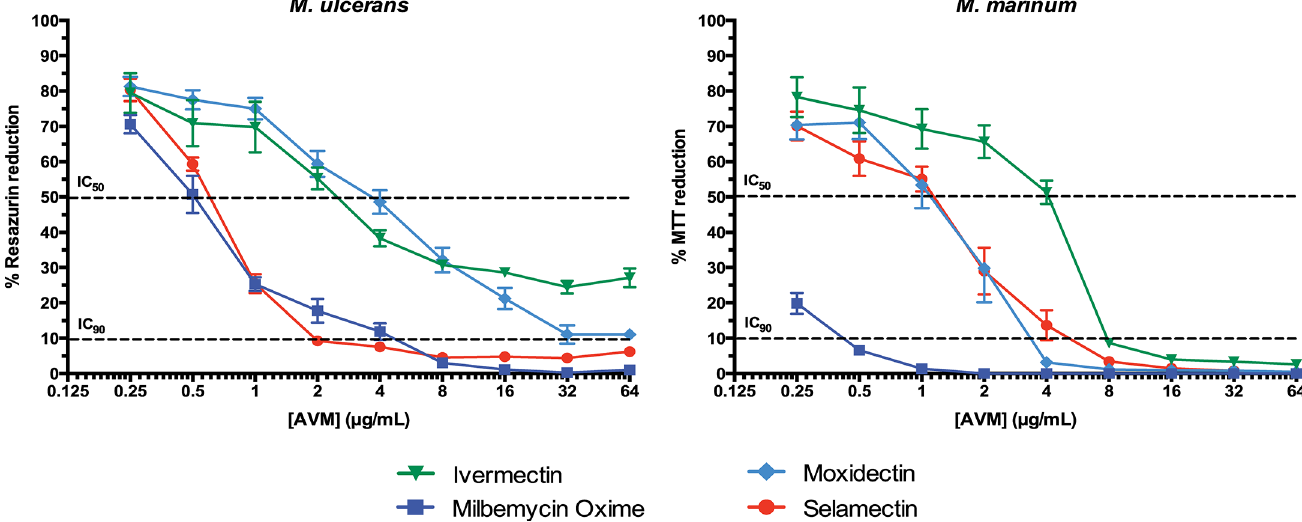
Fig 1. In vitro dose-response of the avermectins against M . ulcerans and M . marinum . Values are the mean of activities against three M . ulcerans and two M . marinum clinical isolates (see Table 1) performed in triplicate. IC 90 and IC 50 , 90% and 50% reduction of resazurin or MTT color conversion, respectively.